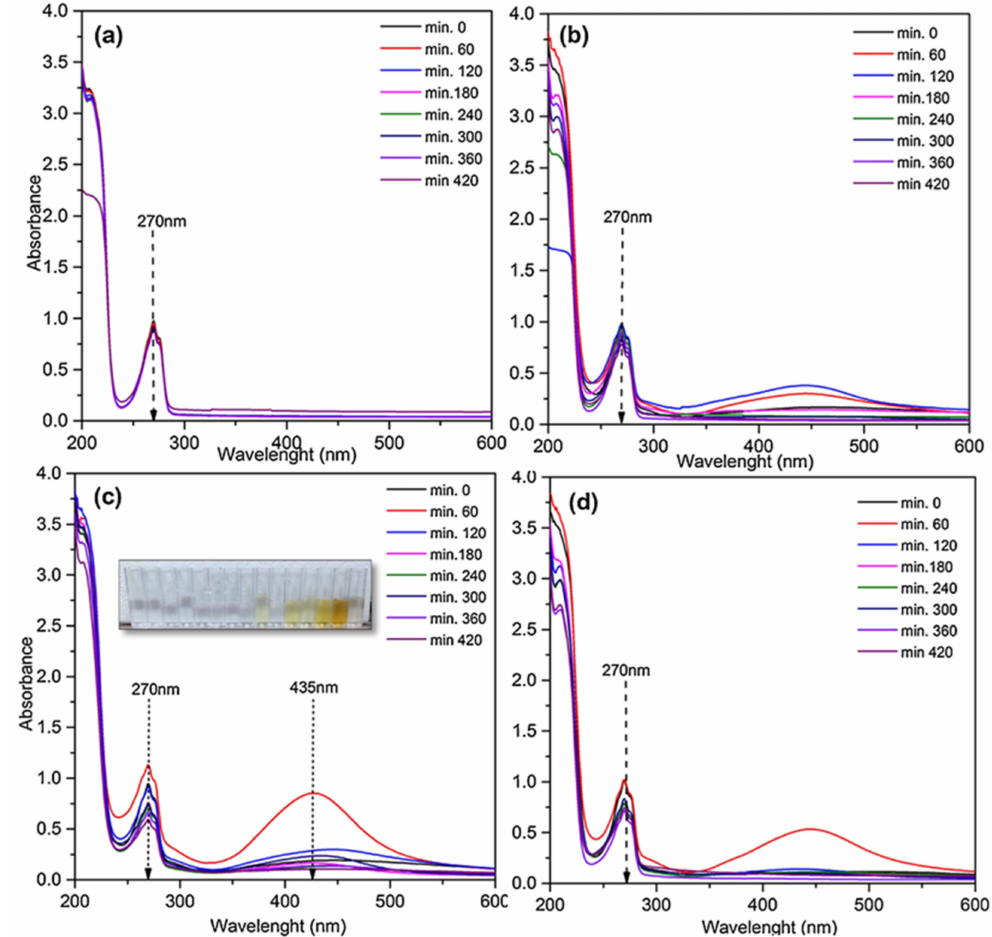
Figure 9. UV-vis spectra of phenol photo-oxidation process in the presence of ( a ) ZnO, ( b ) ZnO/Ag 2 CO 3 , ( c ) ZnO/Ag 2 CO 3 /Ag 2 O and ( d ) ZnO/Ag 2 O nanocomposites. Reproduced with permission from